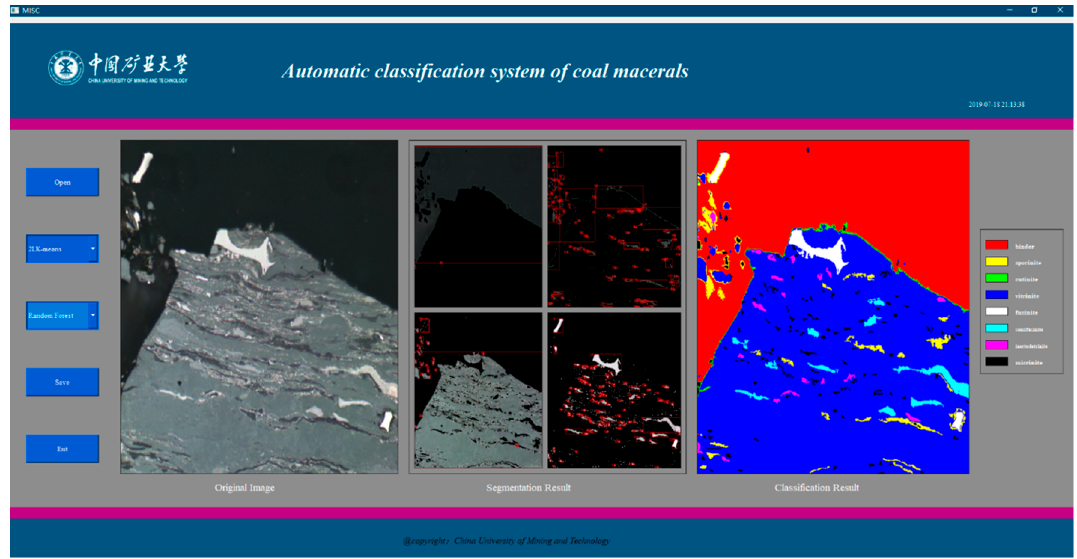
Figure 8. The user interface of MISC for automatic coal petrographic analysis.